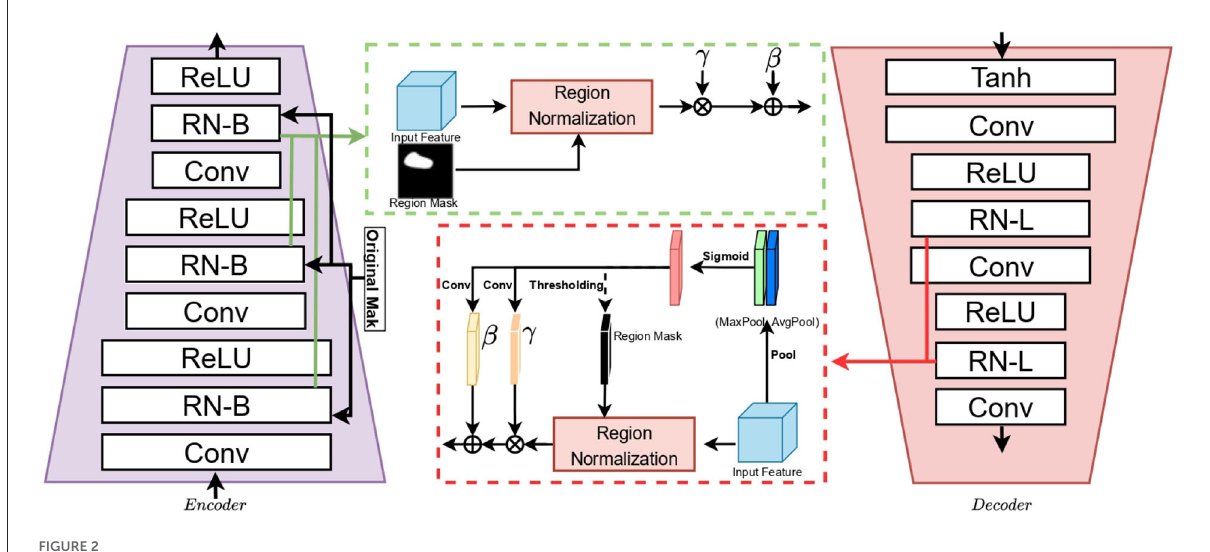
FIGURE2 Structure of encoder and